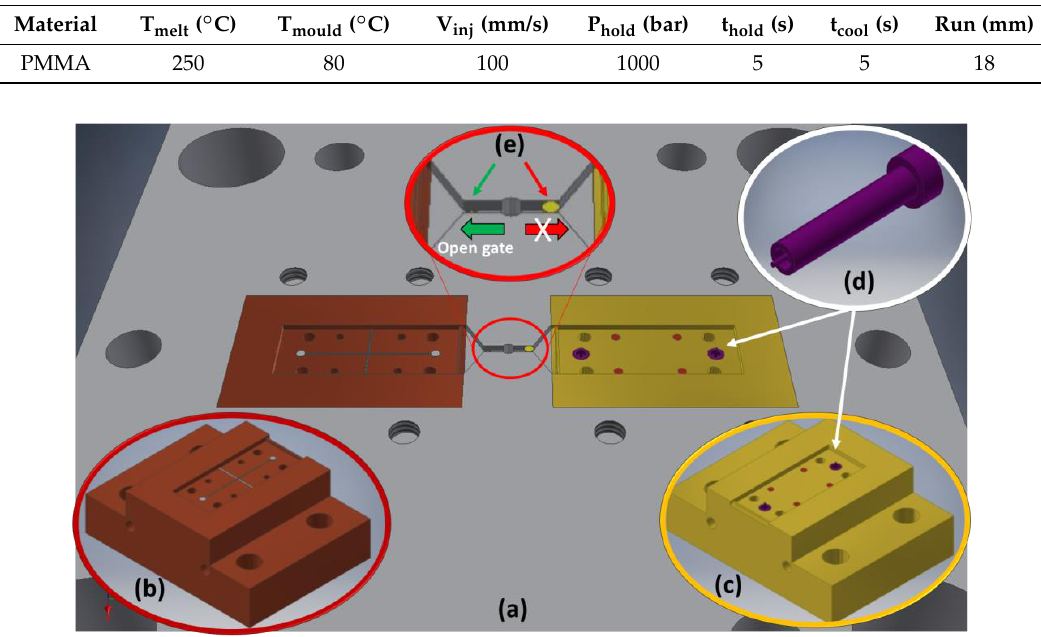
Figure 4. Design of the ( a ) mould plate with runners and gates, ( b )( c ) main features inserts, ( d )